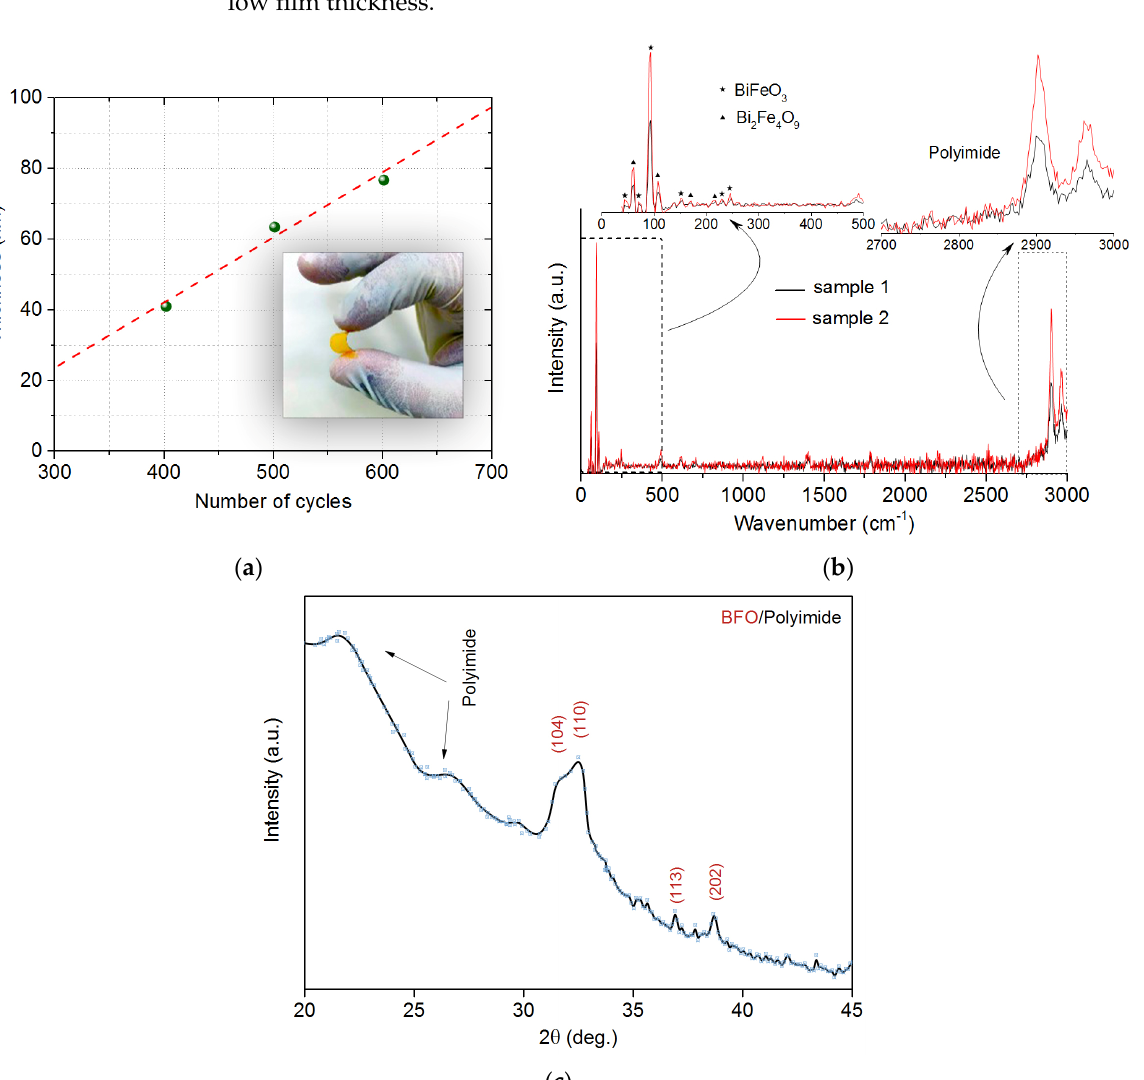
Figure 2. ( a ) Change in film thickness during growth depending on the number of cycles. ( b ) Raman spectrum from the obtained sample BFO/polyimide. ( c ) XRD from sample 2 BFO/polyimide. The Raman spectrum shows that the intensity of a thicker sample is higher than that of a thin one. Functionalization by bismuth occurs in the resulting organometallic binder and charge transfer occurs, a similar peak in the region of 1400 cm − 1 is visible on the Raman spectrum. An ionic bond with Bi 3+ and Bi(NO 3 ) 3 can also be formed [41]. During ALD growth, partial segregation of Bi atoms from the surface region of the substrate was observed during the oxidation of the substrate [25]. The N atoms remain in bond as well as C and O (Figure 3). The width and intensity of the peaks of the Raman spectrum (Figure 2b) correspond to the form of oxidation of bismuth. It was also possible to observe photoluminescence, which is a consequence of the partial self-organization of Bi-O as a result of laser irradiation and the presence of oxygen vacancies. As expected, it was